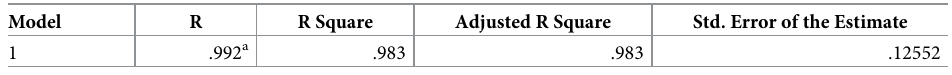
Table 4. Model summary of service innovation practices and customer loyalty. Model